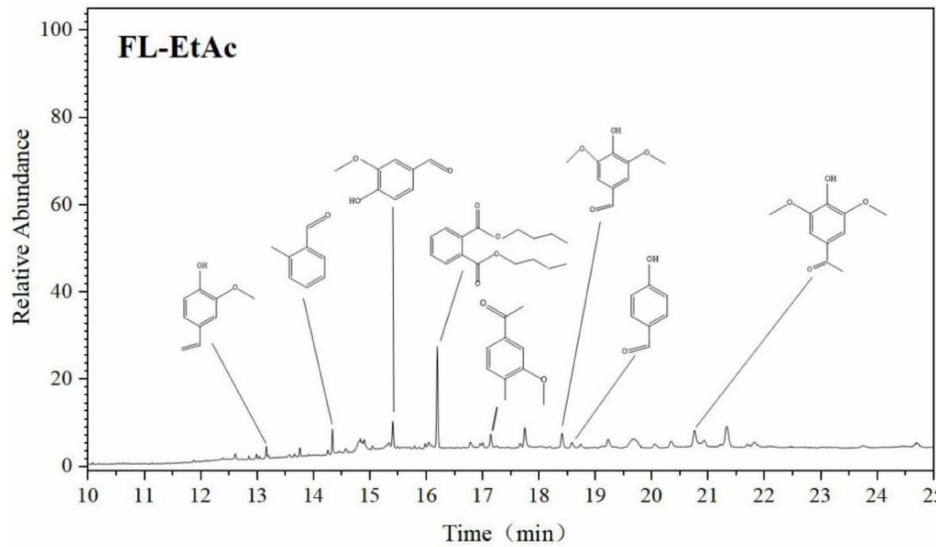
Figure 5. GC/MS analysis for the aromatic monomers in FL-EtAc fraction.